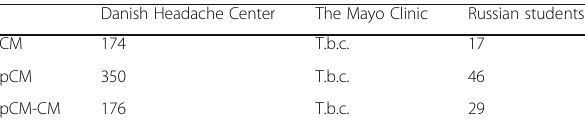
Table 1 (abstract P147). Number of migraine patients